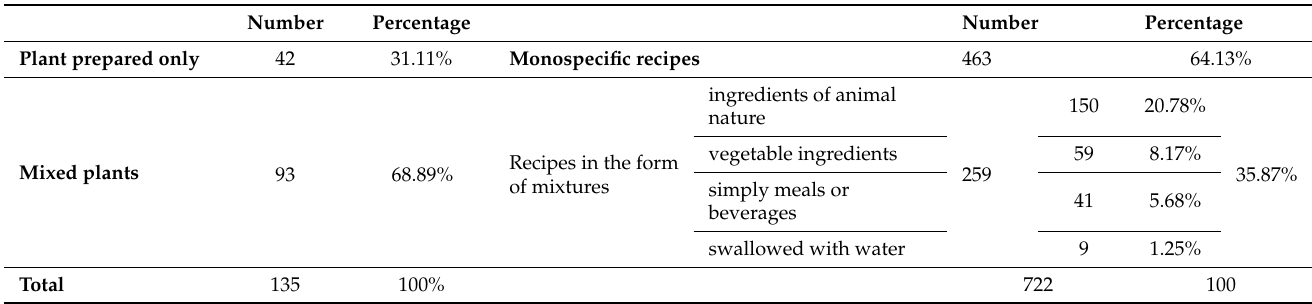
Table 4. Description of the